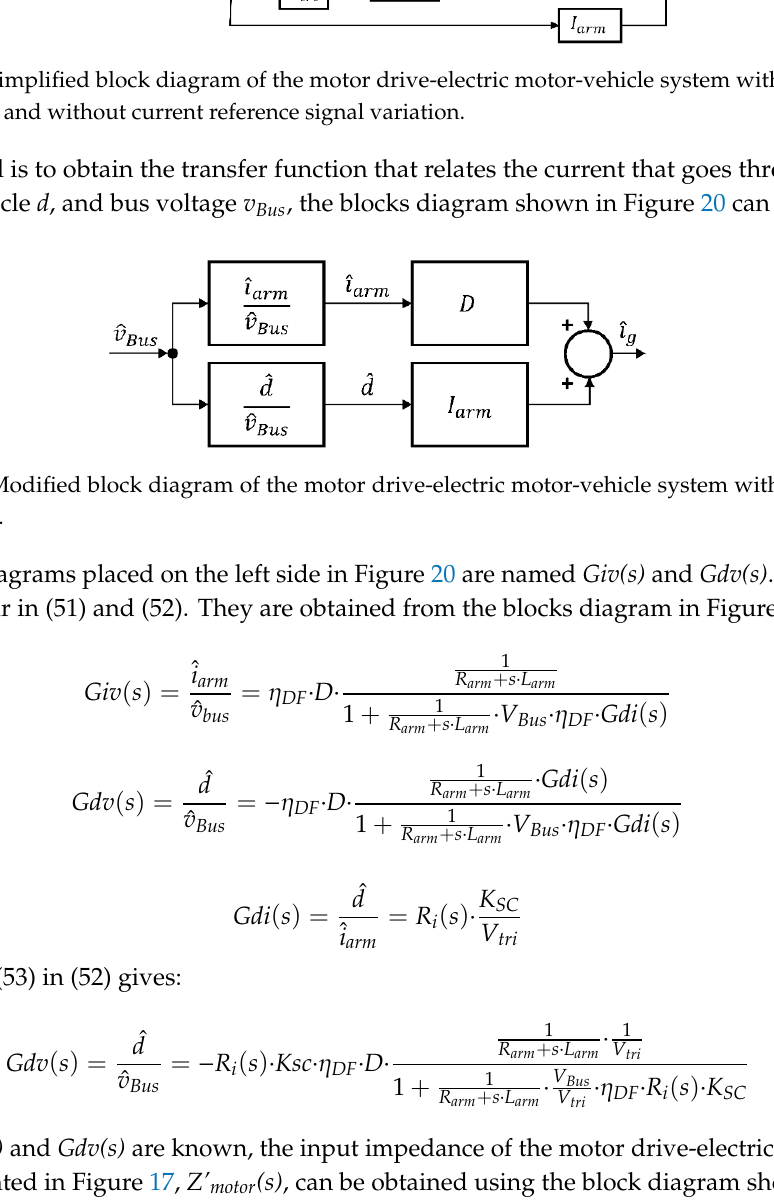
Figure 19. Simplified block diagram of the motor drive-electric motor-vehicle system with the inner control loop and without current reference signal variation.